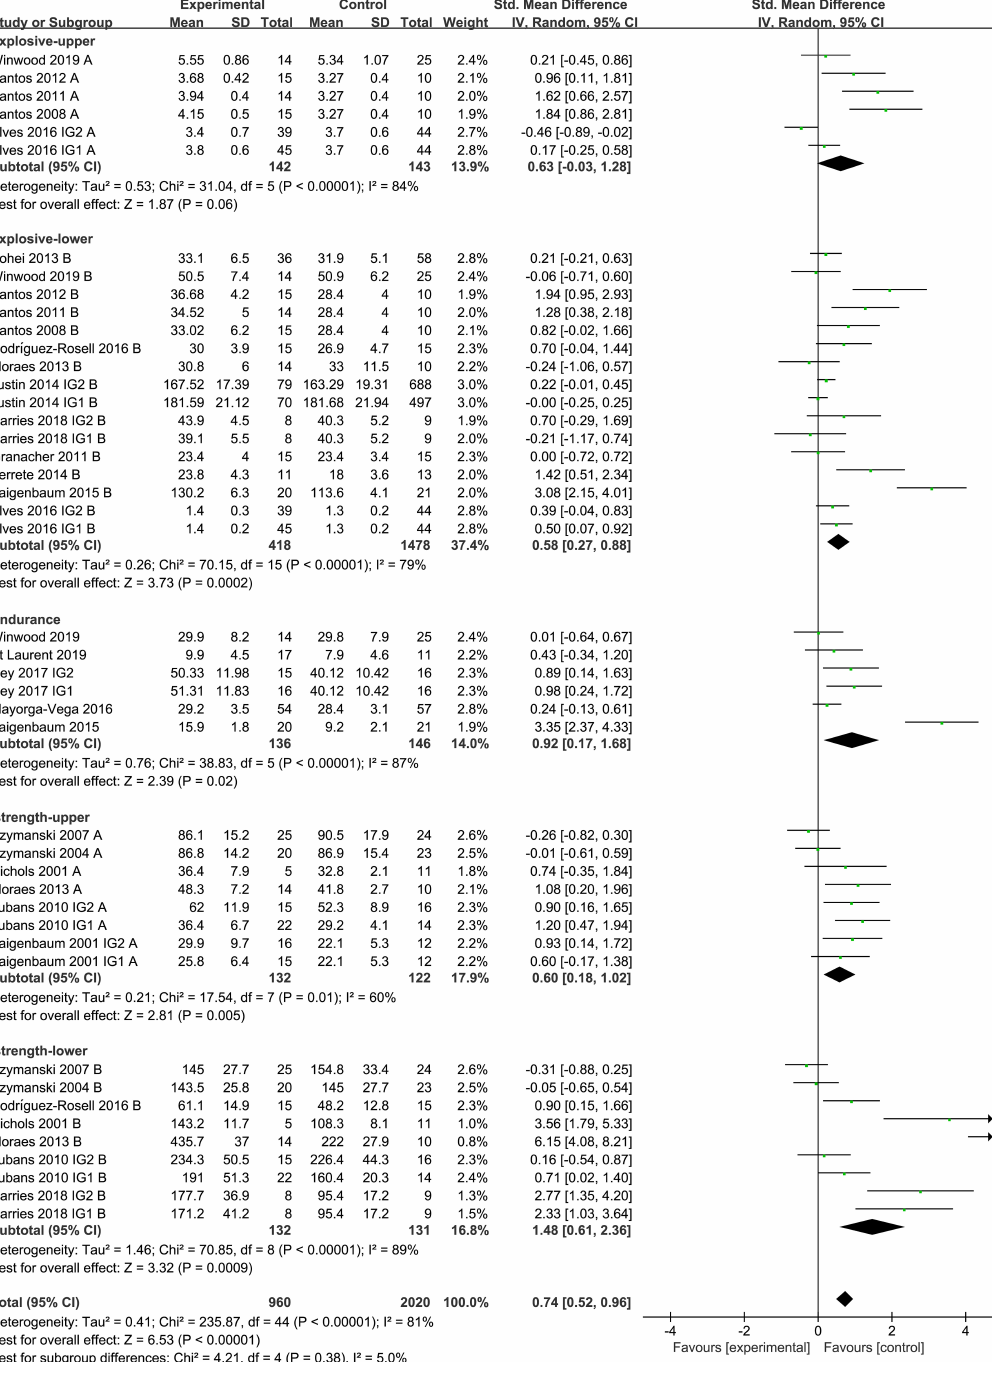
Figure 3. Effect of physical activity on the muscle strength and explosive of the upper and lower limb. IG1: intervention group 1; IG2: intervention group 2; A: upper limb; B: lower